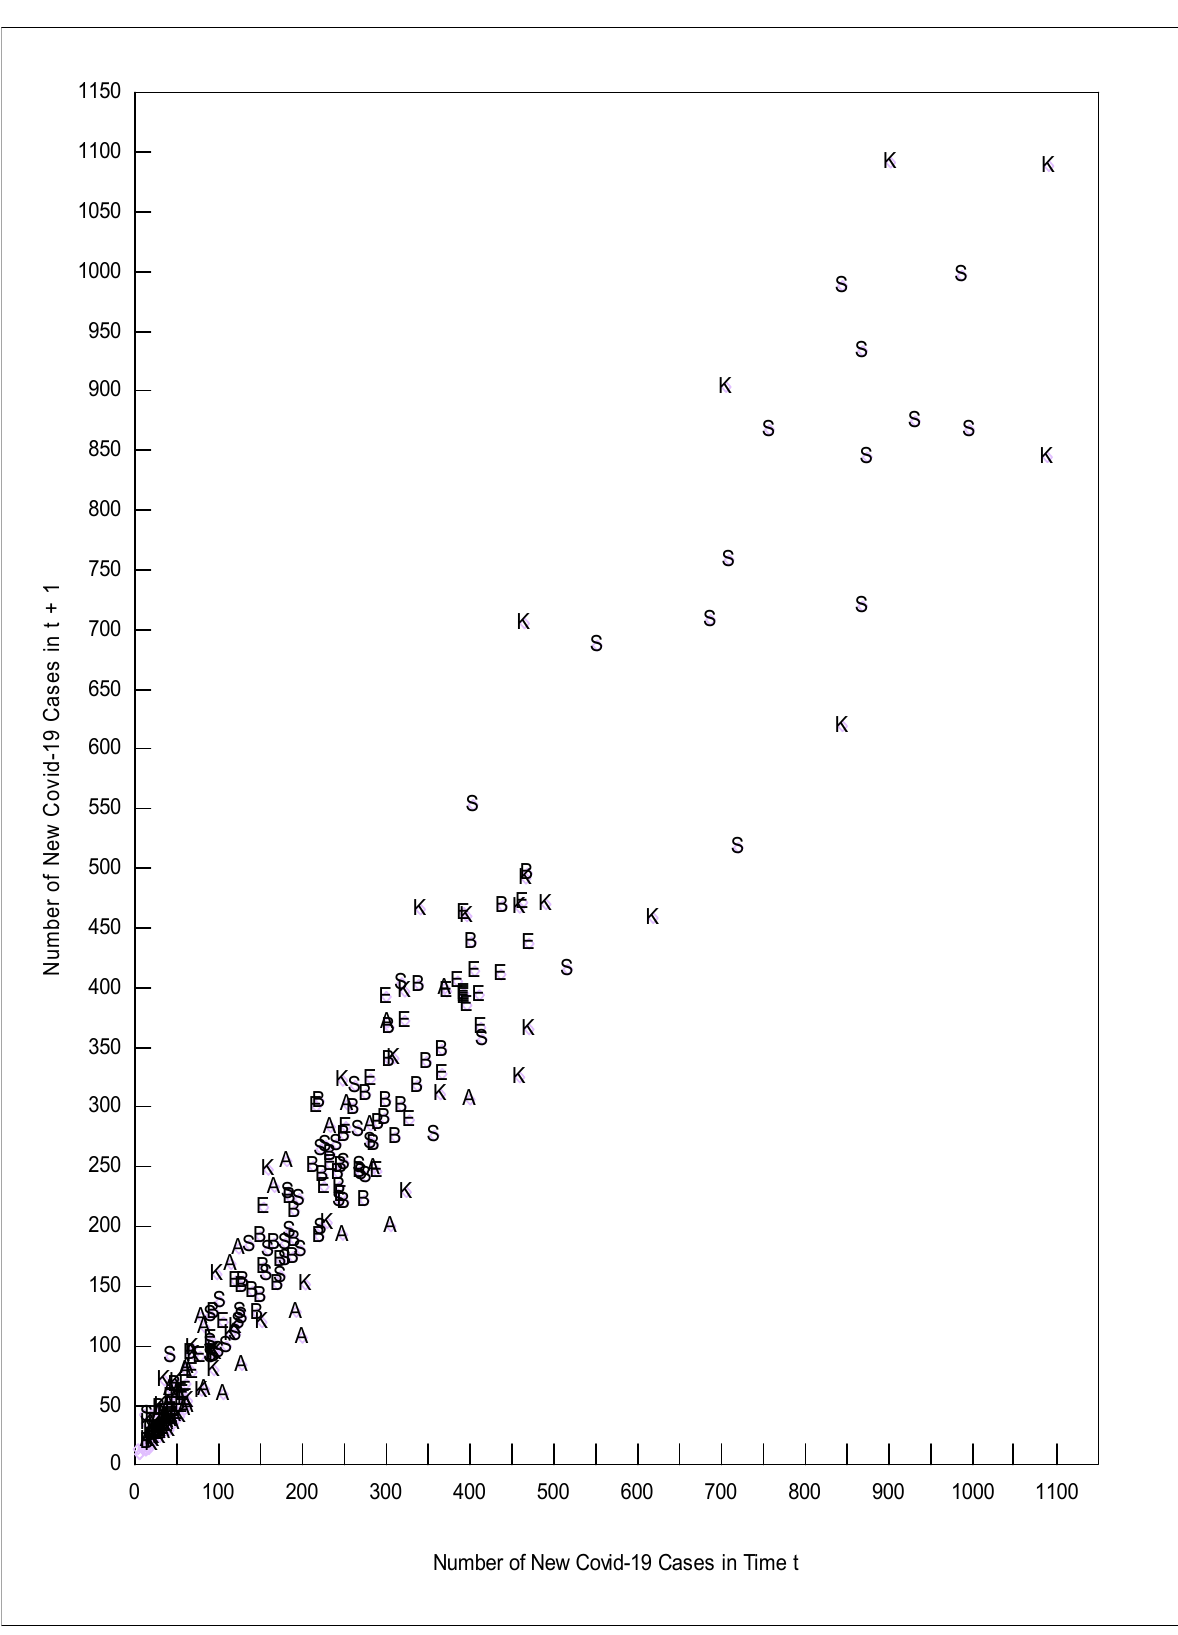
Figure 2. New cases of COVID-19 in t + 1 ( y axis) versus new cases in t ( x axis). A = South Africa, B = Brazil, E = Europe, K = United Kingdom, S = USA.